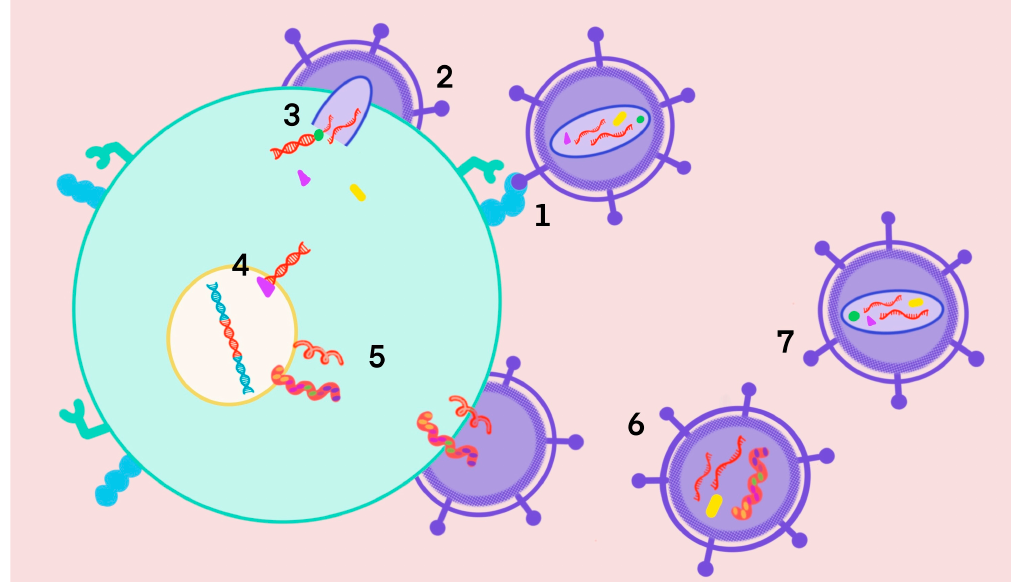
Figure 1. HIV replication cycle.